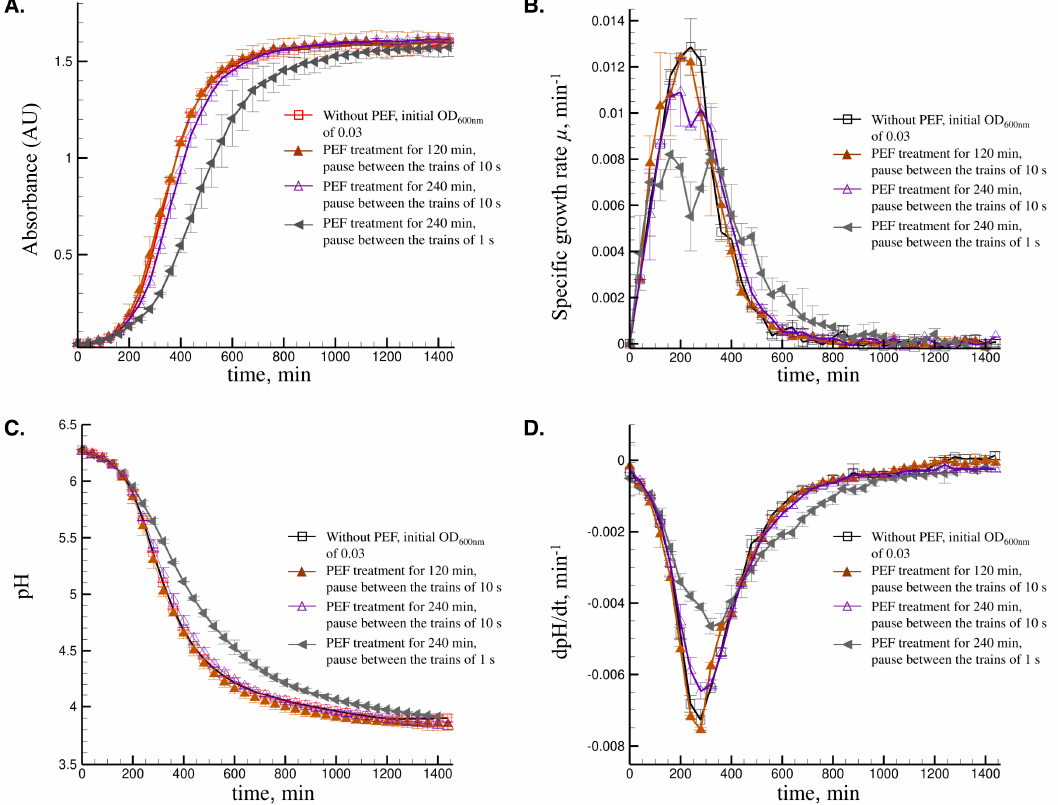
Figure 4. Growth and acidification kinetics of L. delbrueckii subsp. bulgaricus CFL1 in MRS broth under different PEF treatment parameters. Fermentations were performed with an initial OD 600nm of 0.03. □ , kinetics without PEF treatment. PEF-assisted fermentations were performed at the intensity of 285 V cm − 1 . ▲ , PEF treatment for 120 min with a pause between the trains of 10 s. ∆ , PEF treatment for 240 min with a pause between trains of 10 s. ◄ , PEF treatment for 240 h with a pause between trains of 1 s. ( A ) Absorbance (AU) of the medium, ( B ) Specific growth rate µ , ( C ) pH values of the medium, ( D ) Acidification rate dpH/dt. Vertical error bars represent the standard deviation of three biological replicates.